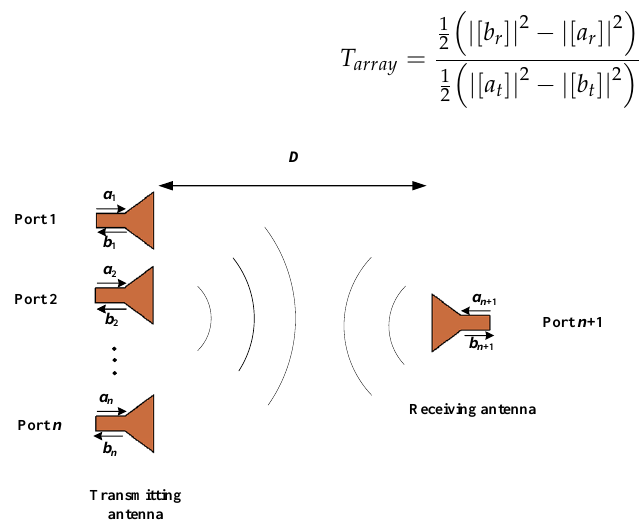
Figure 1. The basic model of power transmission system.